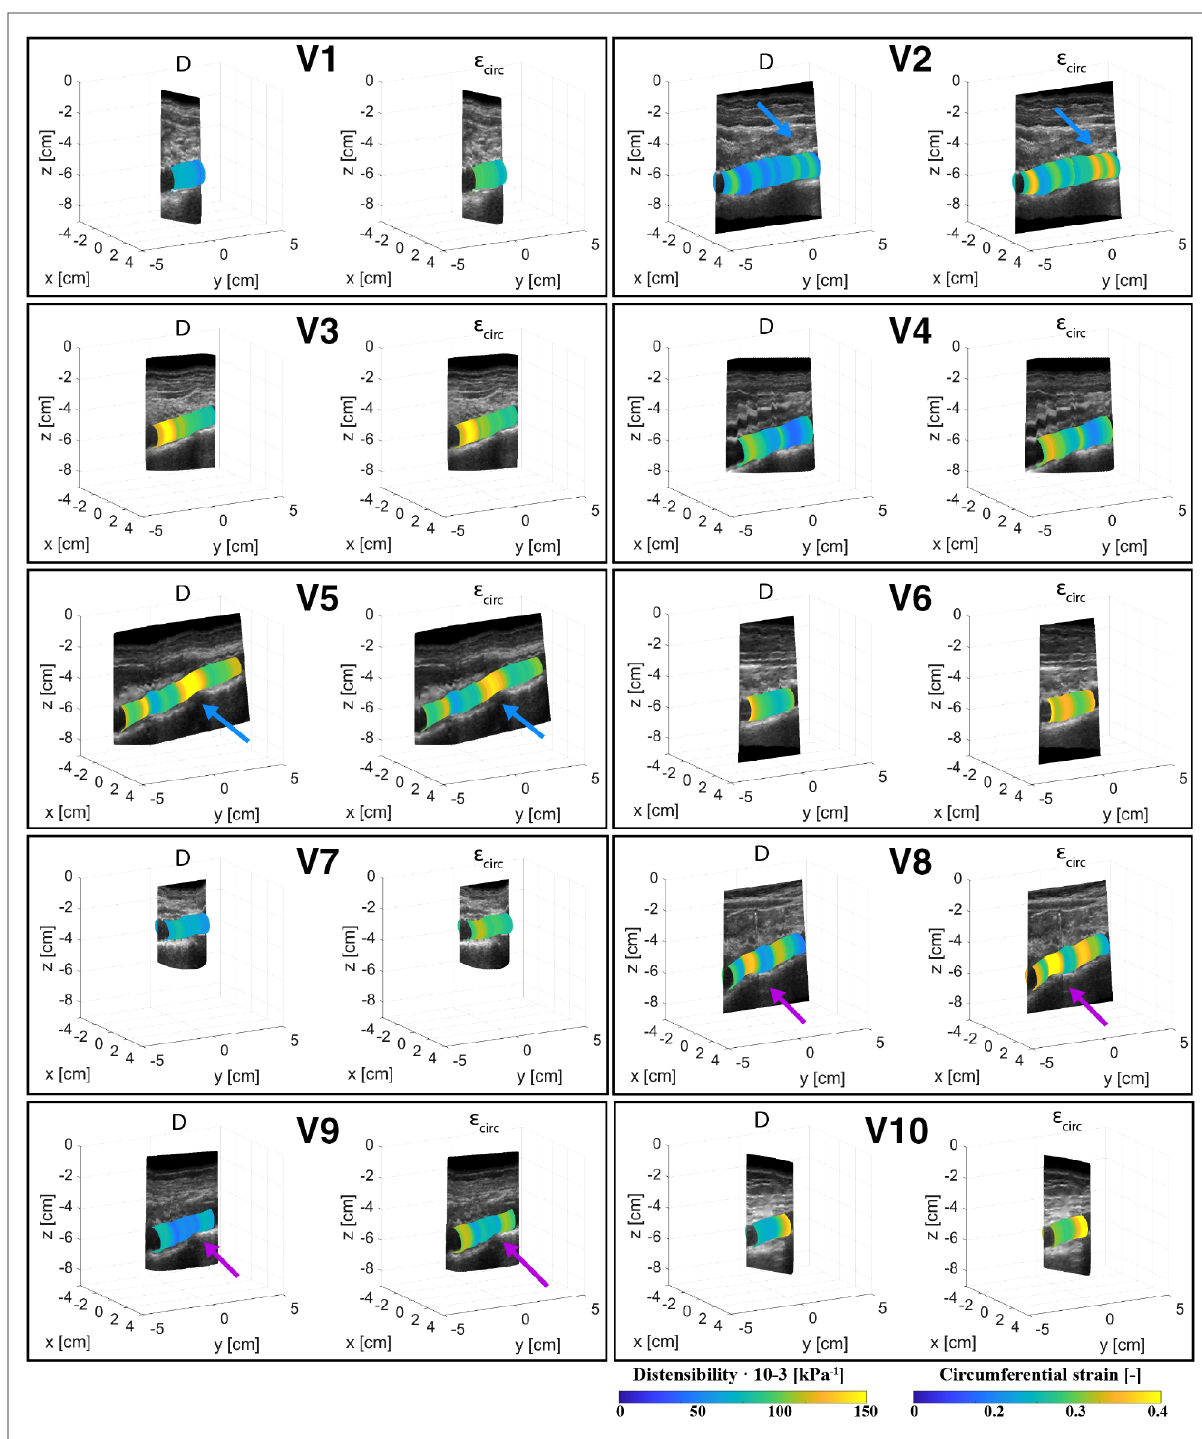
FIGURE 4 Overview of the assessed mechanical properties distensibility, D·10 − 3 (kPa − 1 ), and circumferential strain, 1 circ ( − ), of volunteers V1 – V10 mapped onto the mean arterial pressure state geometry and visualized with an interpolated cross-section of the acquired US images. Blue arrows point at locations of poor echogenicity and purple arrows point at regions where the vessel direction